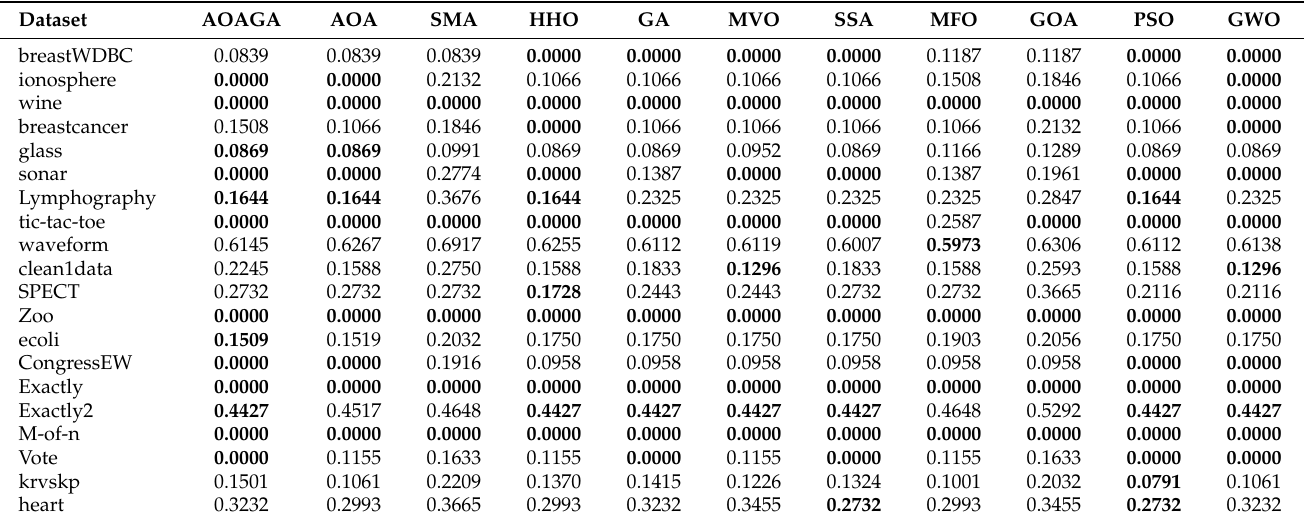
Table 3. Results of the MIN measure for all methods.